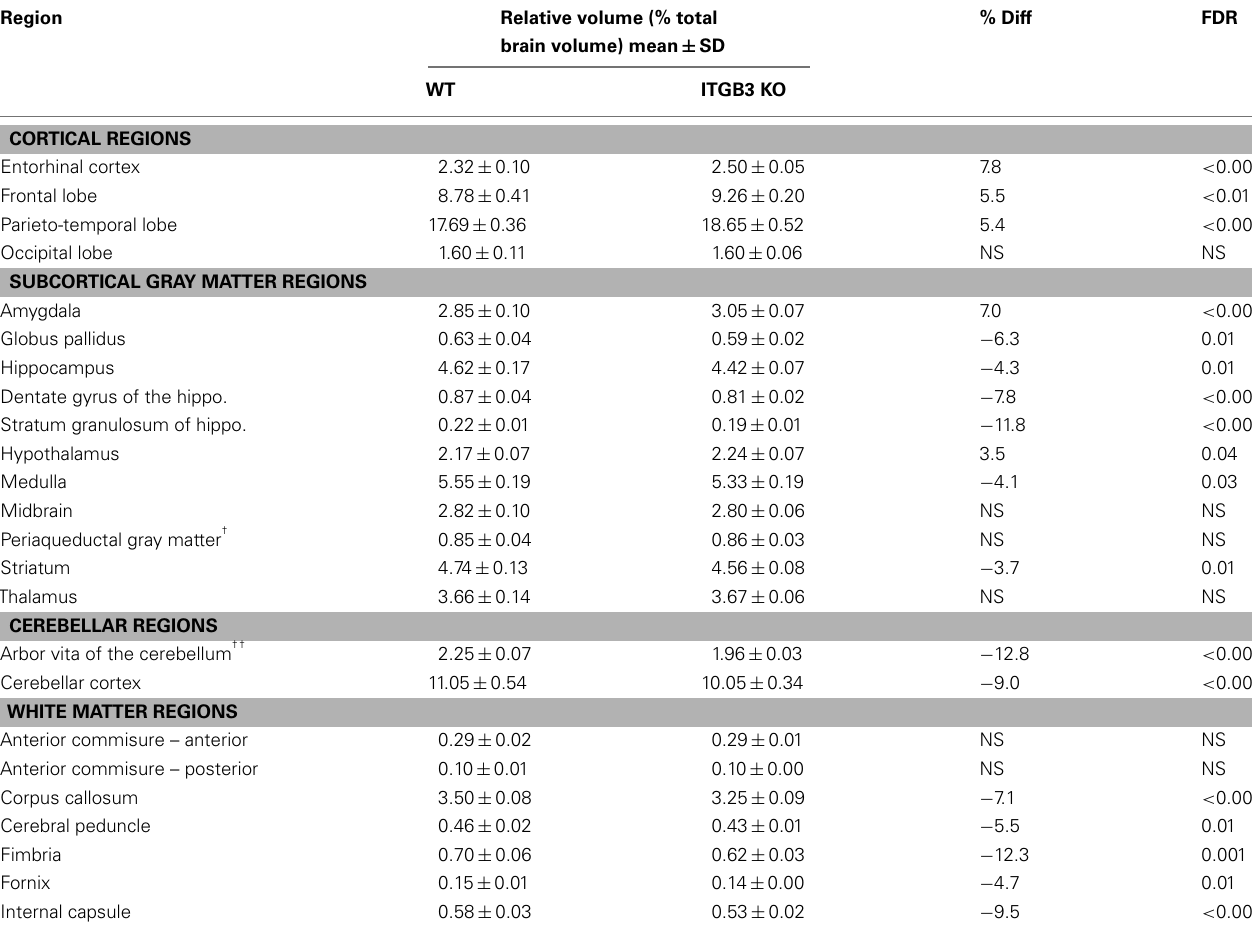
Table 1 | Relative volume measurements (mean ± SD) of selected regions in the ITG β 3 KO compared to the